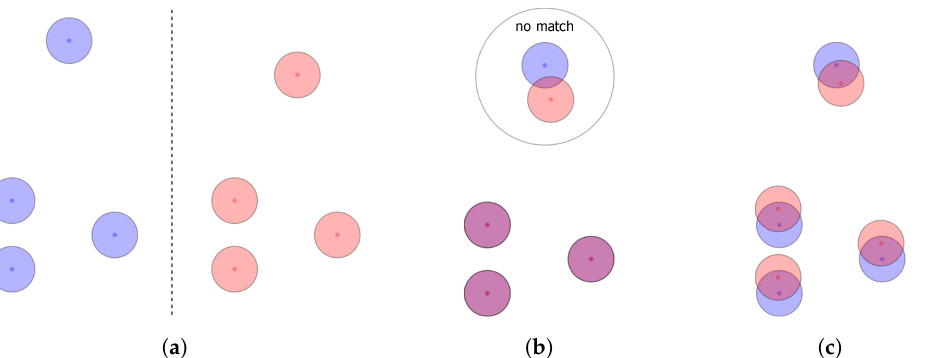
Figure 1. Illustration of different pharmacophore alignment strategies and the thus obtained results ( b , c ). For the sake of simplicity, pharmacophores ( a ) consist only of features of the same type. Different colours are just used to distinguish the pharmacophores. ( b ) Result from RMSD- or volume-based alignment. ( c ) Max. matching feature count-based